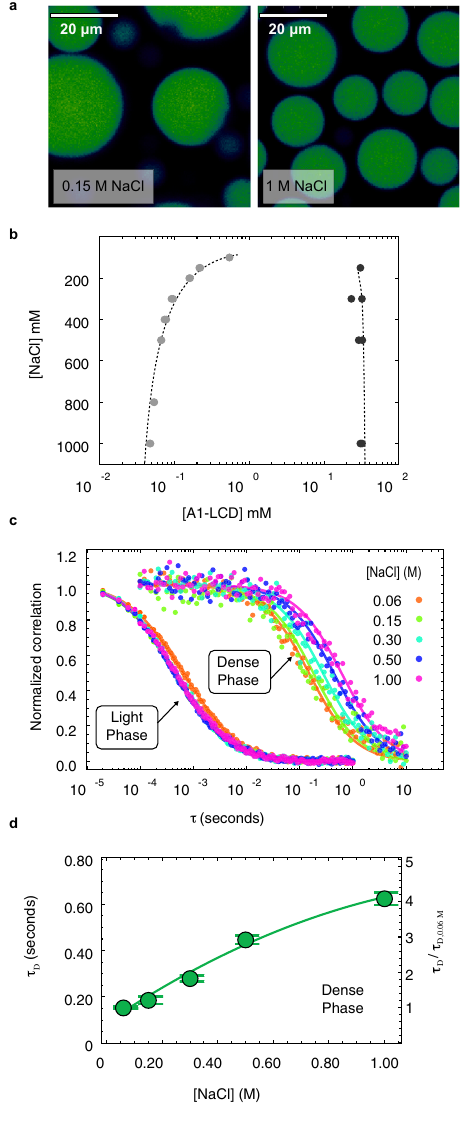
Fig. 2 NaCl promotes equilibrium phase separation of A1-LCD. a Confocal microscopy images of fl uorescently labeled A1-LCD droplets at 0.15 M NaCl and 1 M NaCl. Many fi elds of view from two independent replicates were examined with consistent results. Images are displayed with false-color determined by fl uorescence intensity. b A1-LCD binodal mapped by UV absorption concentration measurements of coexisting dilute and dense phases as a function of NaCl concentration. The saturation concentrations at each NaCl concentration were measured independently for three different samples and all individual data points are displayed (light gray, overlapping). Dense phase concentrations for each NaCl concentration were measured from two different samples (dark gray). The gray dashed line serves to guide the eye. c Normalized correlations in the dilute (left) and dense phases (right) as a function of NaCl concentration. Experimental conditions were the same as above but in presence of 1 mM BME. d The FCS lag time inside droplets ( τ D in Supplementary Eq. 10) as a function of NaCl concentration. The right axis shows the relative value with respect to the value measured at 60 mM NaCl, re fl ecting the change in apparent viscosity due to the salt concentration. The green line is a fi t to a second- order polynomial. Two measurements from two independent droplets were averaged and used to fi t τ D . Error bars represent the standard error of the fi